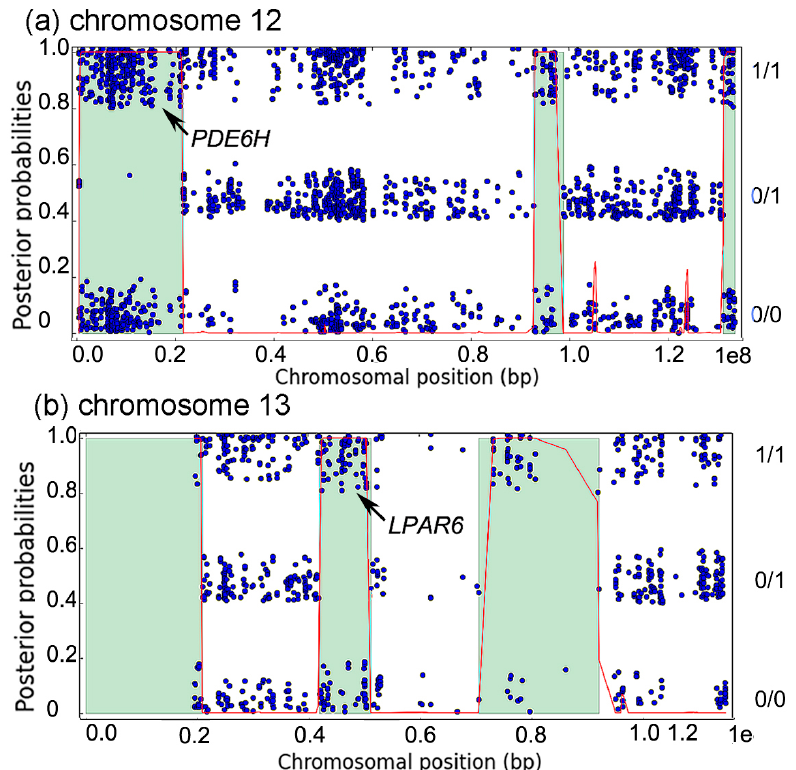
Figure 2. ( a–b ) Autozygosity analysis of chromosomes 12 and 13 in patient II:1. Each blue dot represents a variant. It is placed in the lower band if homozygous for the reference allele (0/0), in the middle band if heterozygous (0/1), and in the top band if homozygous for a non ‐ reference allele (1/1). The red curve shows posterior probability of autozygosity, and predicted autozygous regions are colored in light green. The autozygous regions containing PDE6H (chromosome 12) and LPAR6 (chromosome 13) are indicated by the arrows.